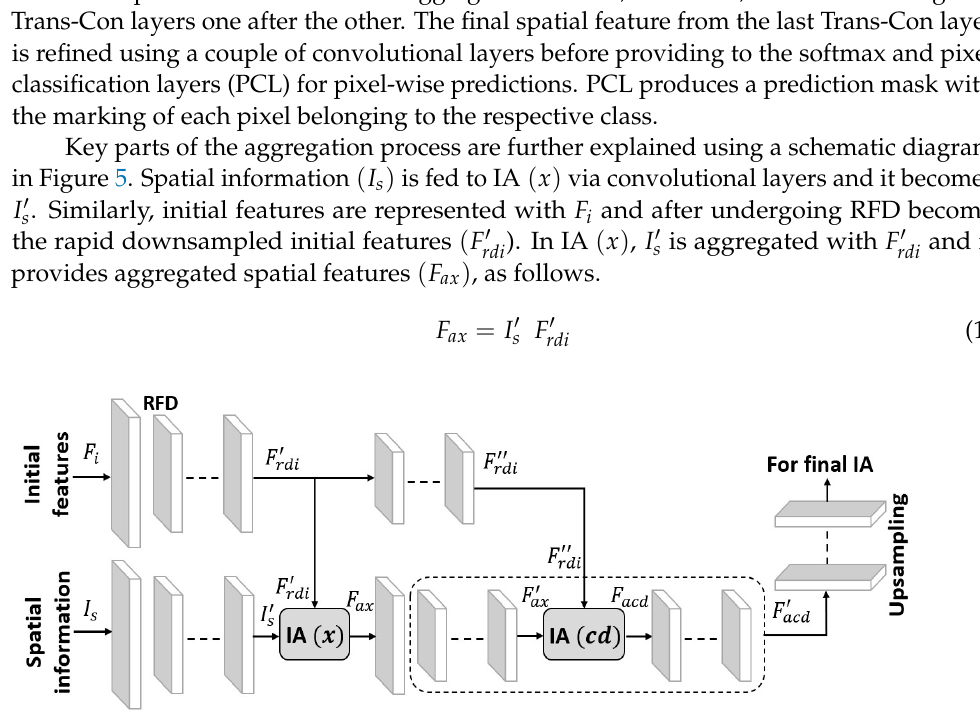
Figure 5. Schematic diagram showing information aggregation in FEDS-Net.